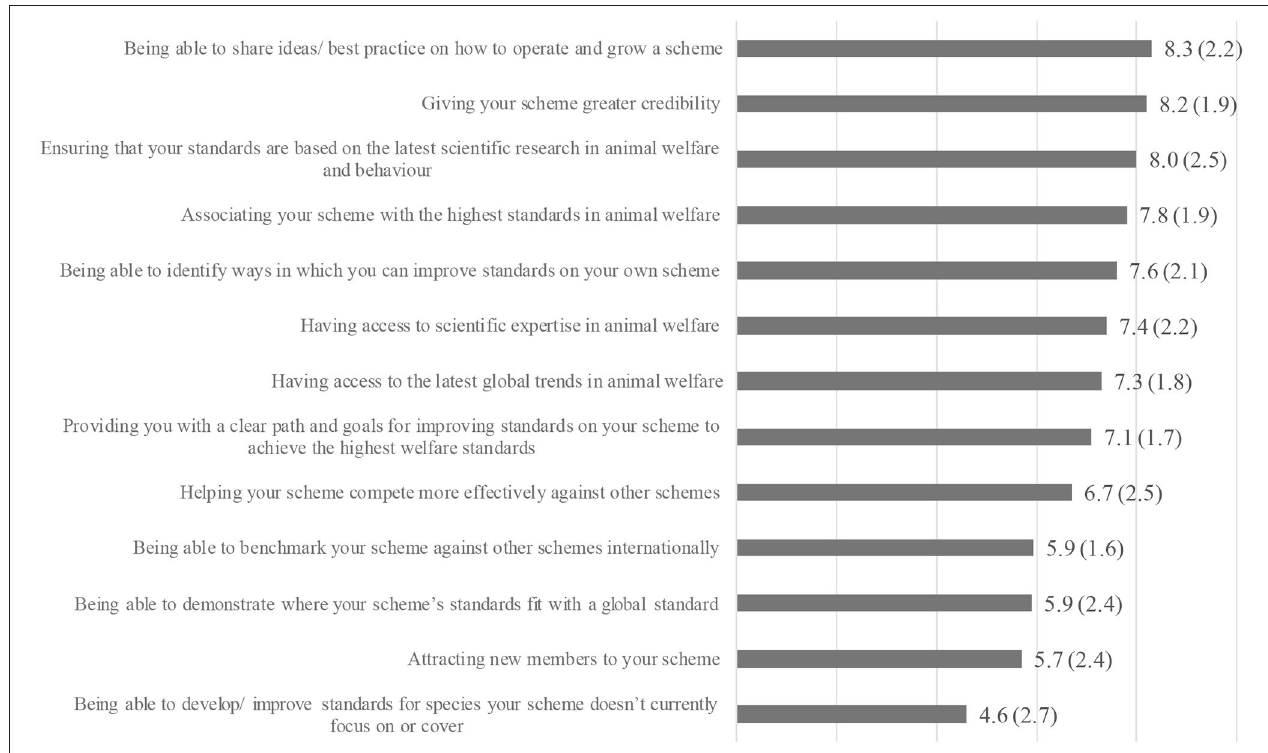
FIGURE 2 | Schemes’ mean ratings (out of 10) and standard deviation (in parentheses) of the importance of potential benefits of being a member of the alliance.